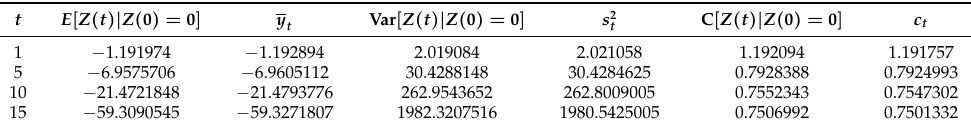
Table 4. For the same choices of the parameters of Figure 9 with ϑ = 0.1, the conditional mean, variance, and coefficient of variation of Z ( t ) are compared with the estimated values y obtained by means of Algorithm